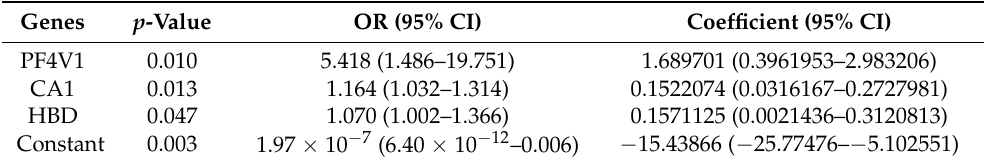
Table 6. Final multivariate logistic regression model including only exosomes significantly associ- ated with the outcome Stage 1 EC patients vs. controls.